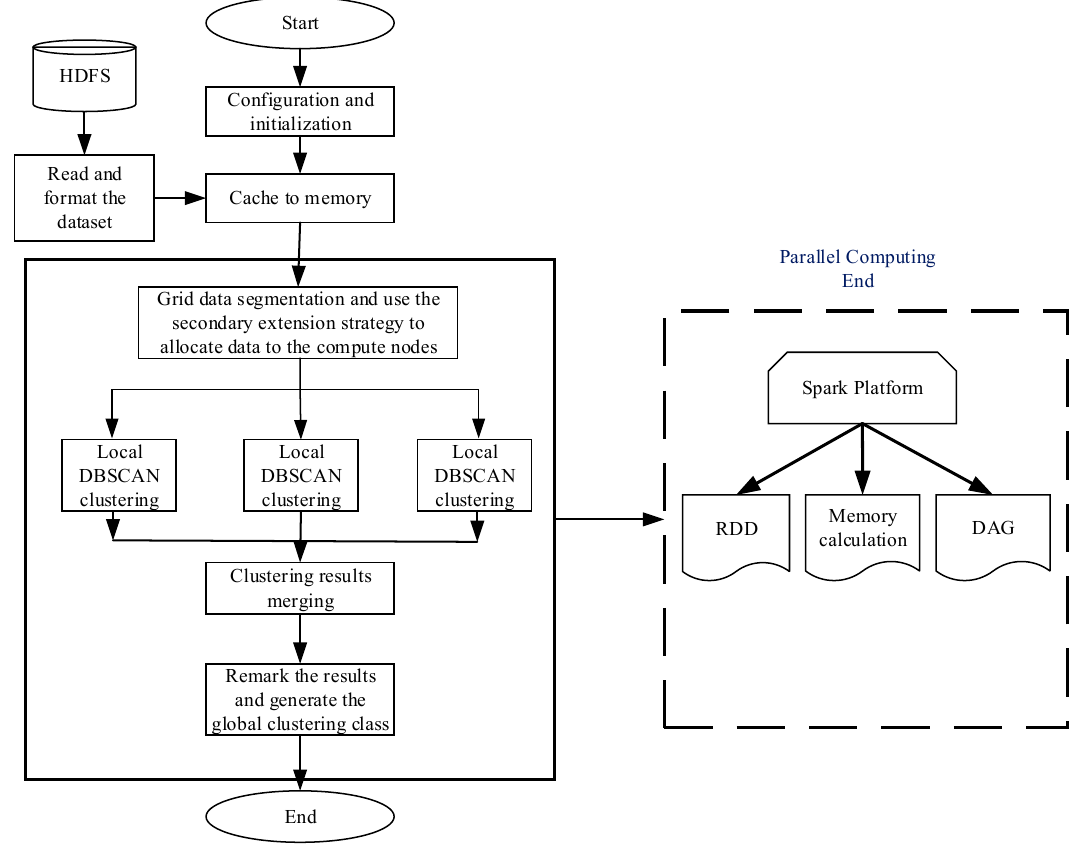
Figure 5. Flow chart of the parallel DBSCAN algorithm.